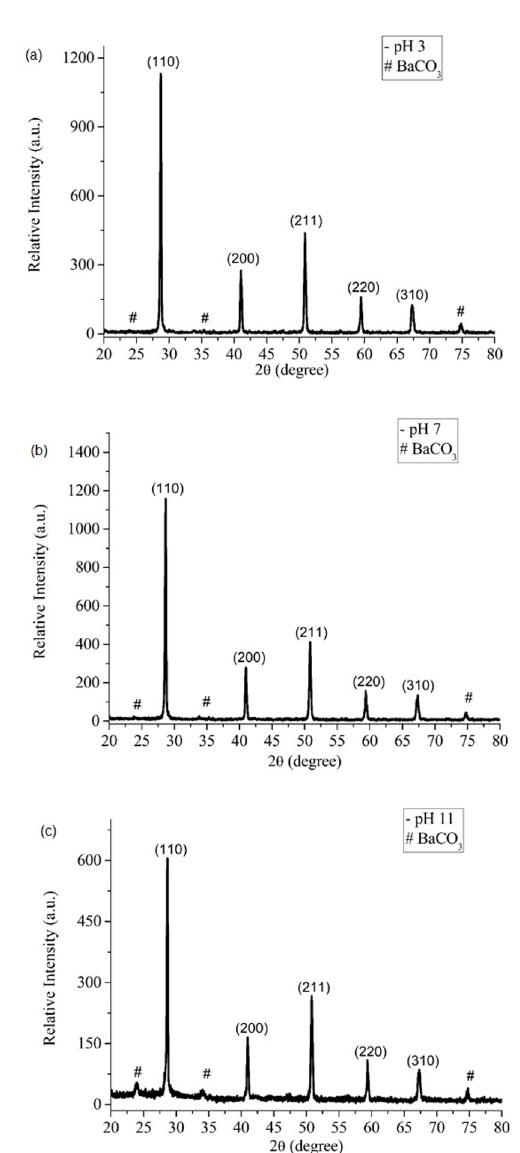
Figure 2. XRD patterns of BaCe with a different pH value after: a) pH 3, b) pH 7, c) pH 11. Table 2. Rietveld refinement data of BaCe pH 3